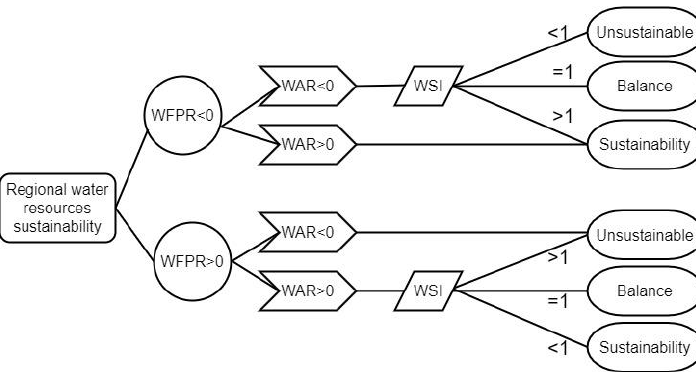
Figure 2. The judgment process of regional water resources sustainability. Table 1. Regional water resources evaluation index system based on WF.